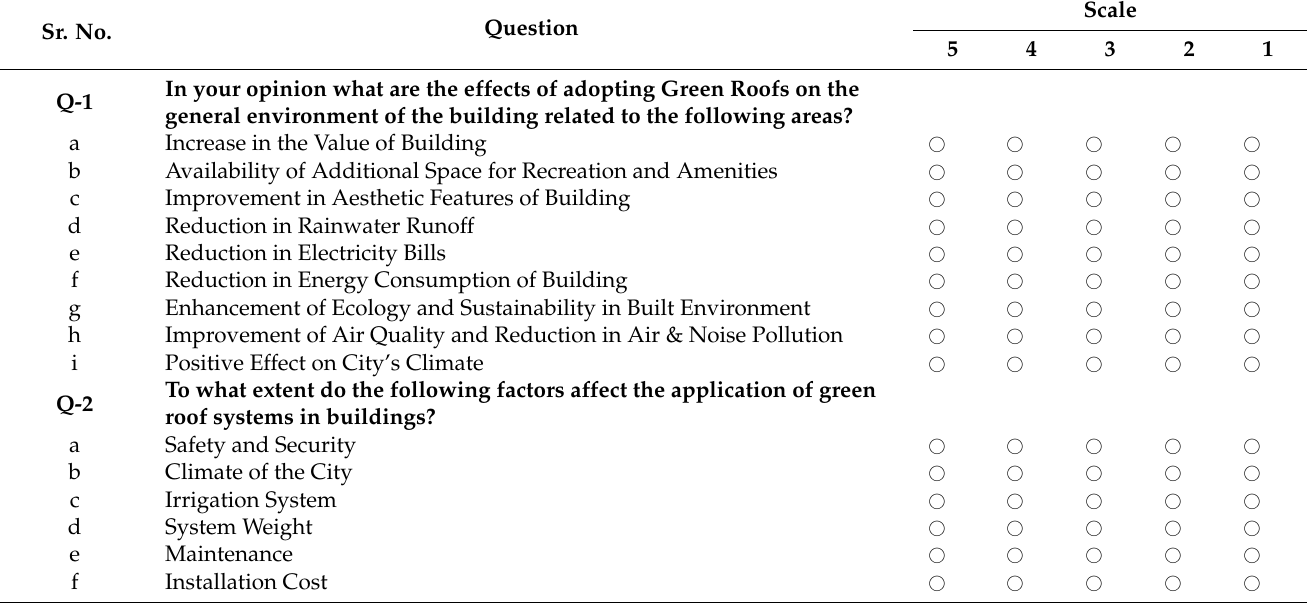
Table 2. Survey questionnaire used for the